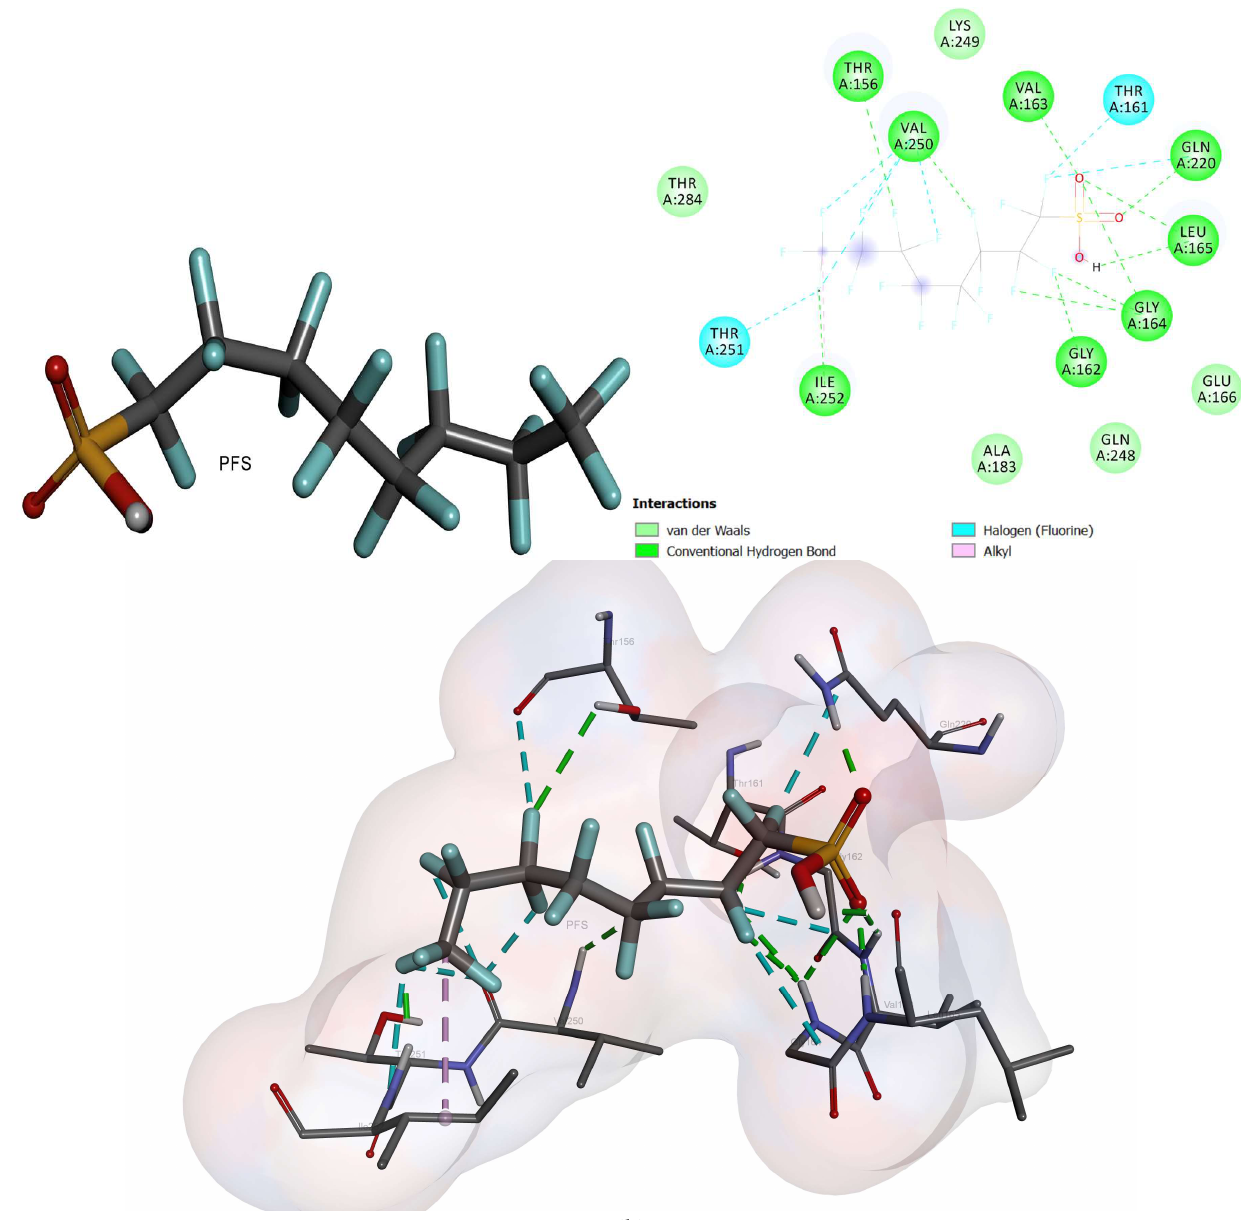
Figure 5. The interactions between photosystem ii d1 c-terminal processing protease and ligands; ( a ) PFOS, and ( b ) PFOA.